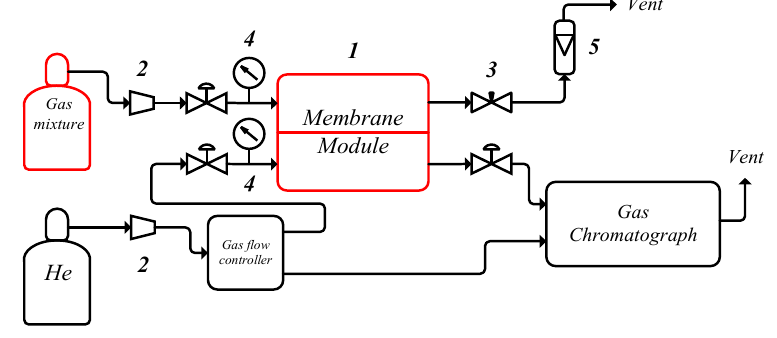
Figure 2. The principal scheme of the experimental setup.